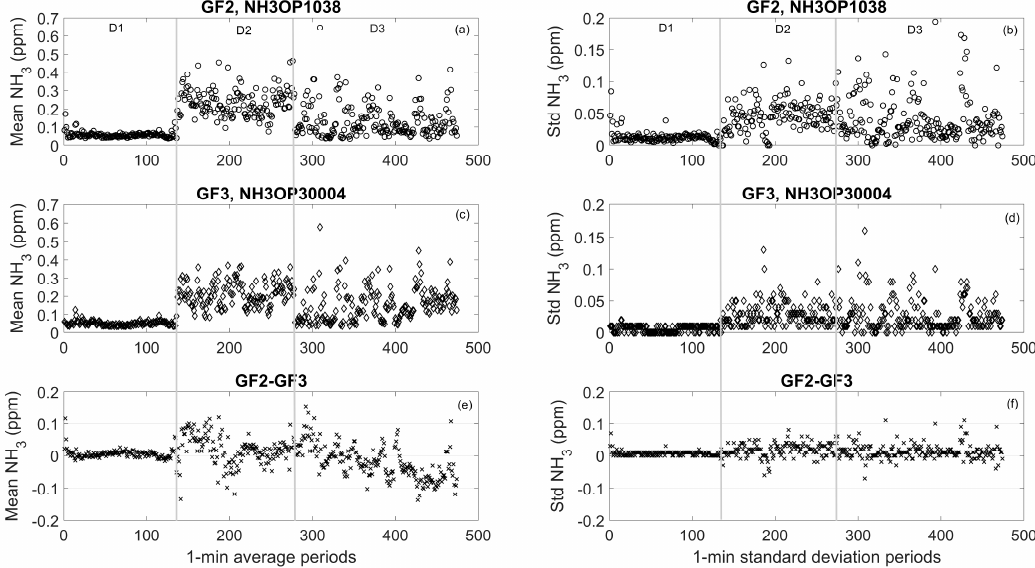
Figure 4. NH 3 concentration measured during three days at the composting facility. ( a , c ) Averaged NH 3 concentration means within 1 min periods of GF2 and GF3; ( e ) difference of averaged means of GF2–GF3; ( b , d ) averaged standard deviations within 1 min periods of GF2 and GF3; ( f ) difference of averaged standard deviations of GF2–GF3. Table 2. Ratios of the means and standard deviations ( σ ) calculated on a 1 min basis of NH 3 concentrations over each measurement period. Averages are on daily basis (D1, D2 and D3) at the composter and before and after fertilizer application at the field trial. P-values from paired difference tests are shown.